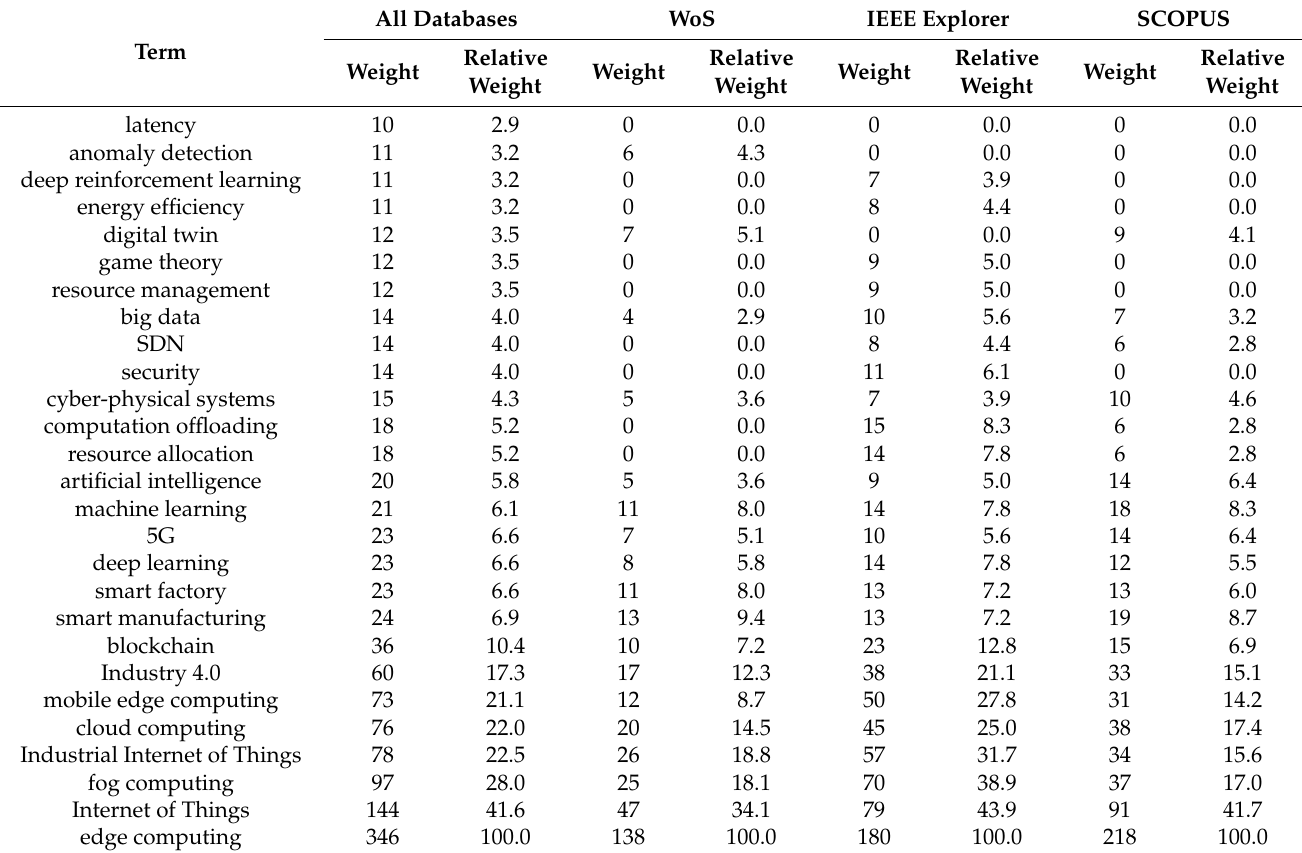
Table 5. Term weights in the analyzed